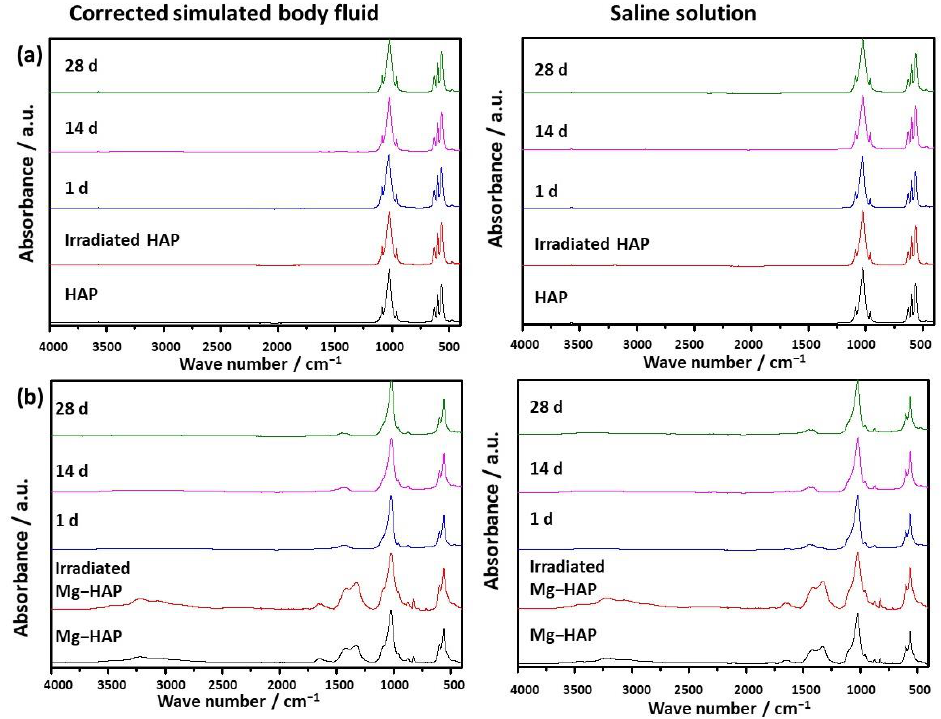
Figure 1. PXRD patterns of ( a ) non-substituted hydroxyapatite (HAP) and ( b ) Mg-substituted HAP (Mg-HAP) starting powder, powder irradiated to 25 kGy, and powders after immersion in corrected simulated body fluid (c-SBF) and saline solution (SS) for 1 – 28 days at 37 °C.